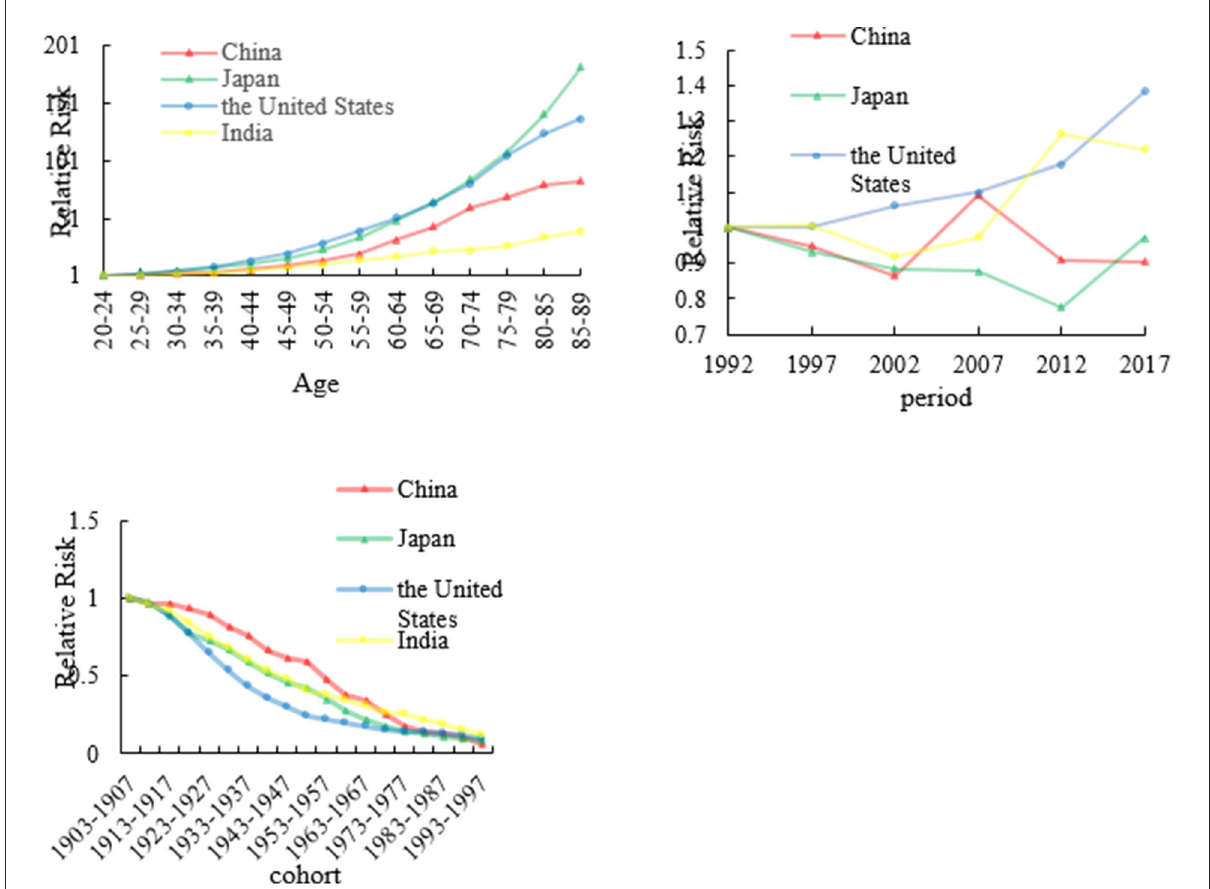
FIGURE4 The age, period, and cohort effects on stomach cancer mortality across four